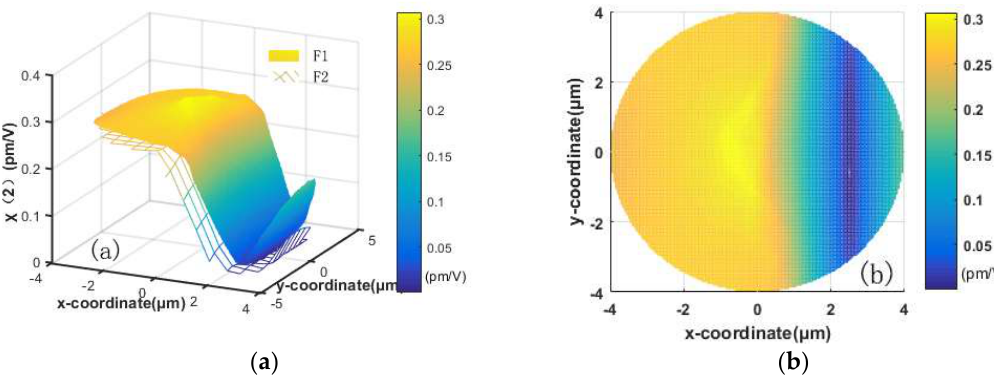
Figure 6. The distribution of the effective second-order nonlinear coefficient induced in the entire core of the fiber F1 after poling of 5420 s and the fiber F2 after poling of 5870 s. A 2D map of effective second-order nonlinear coefficient ( b ) across the fiber core is the top view of the 3D map of it ( a